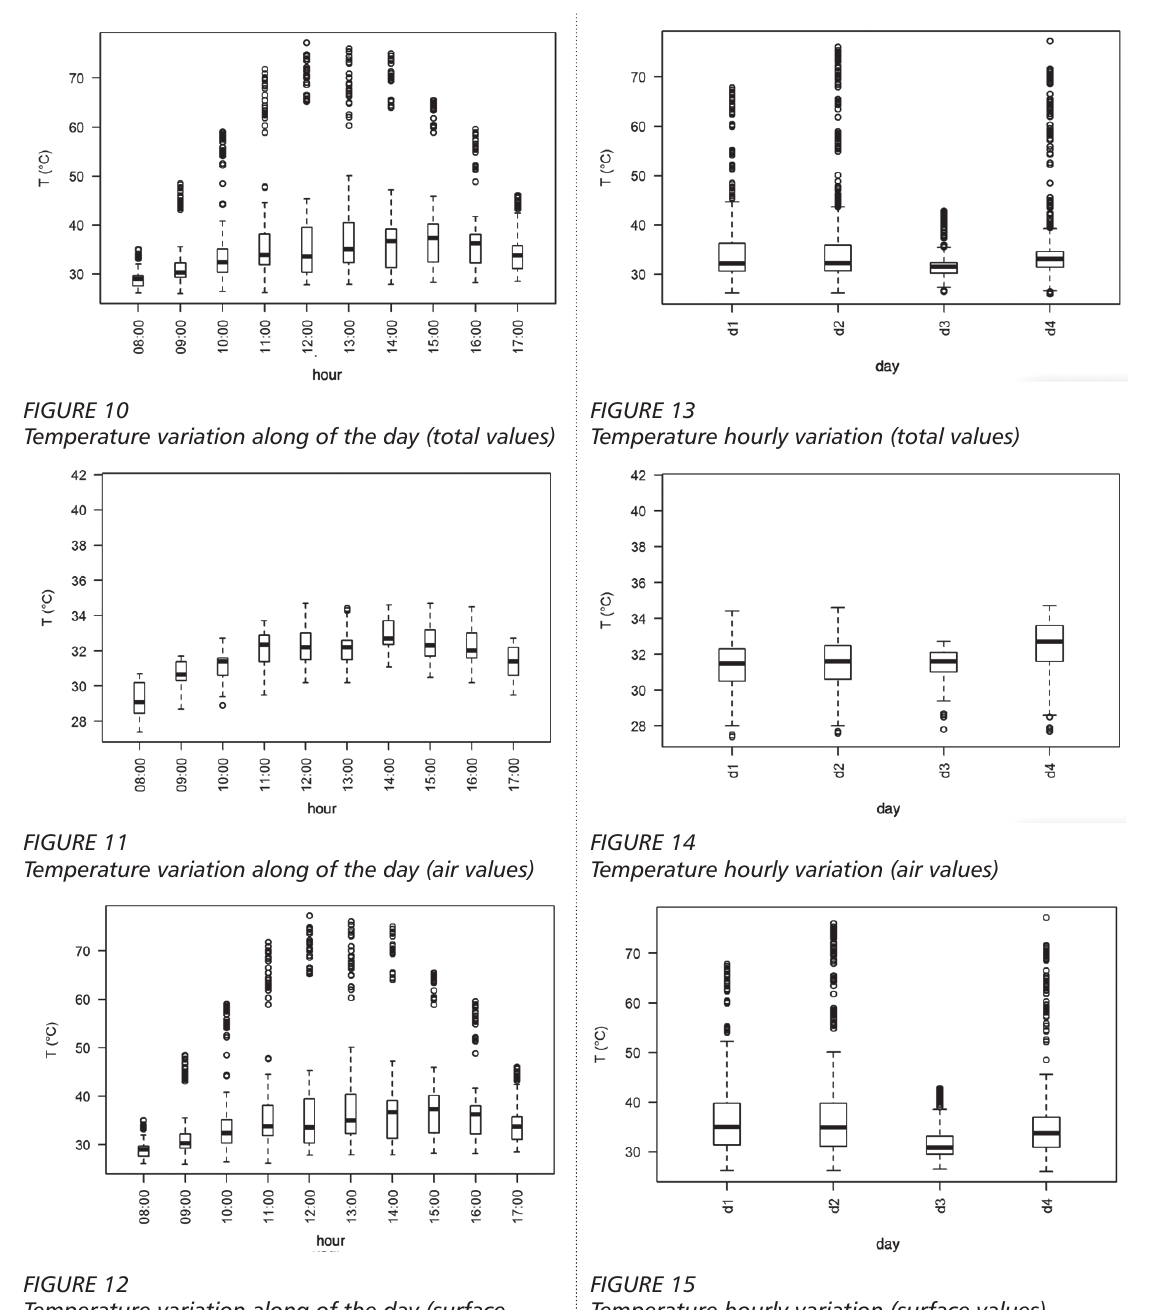
Temperature variation along of the day (surface values) For temperature collected we applied ANOVA and t-test. ANOVA results indicated that the species (kind of shadow) show the greatest influence on entire temperature variability, followed by the hour of the day, the date and the position (with or without shadow) (Figure 19). The kind of shadow is a primary factor for tree services associated with